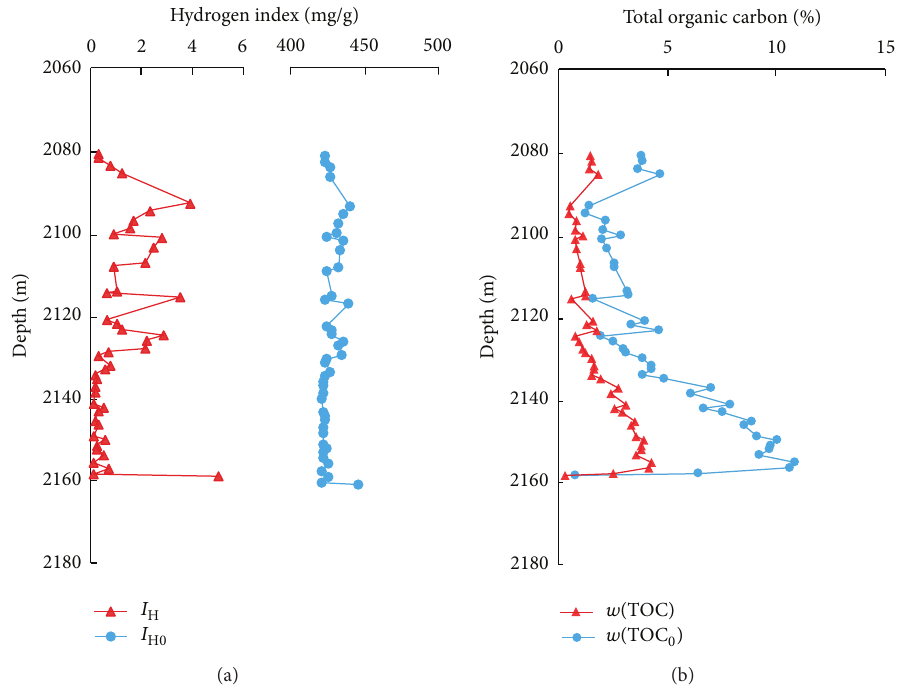
Figure 5: Hydrogen index and total organic carbon values of the Py1 well from Longmaxi Shale in southeast Chongqing. (a) Hydrogen index. (b) Total organic